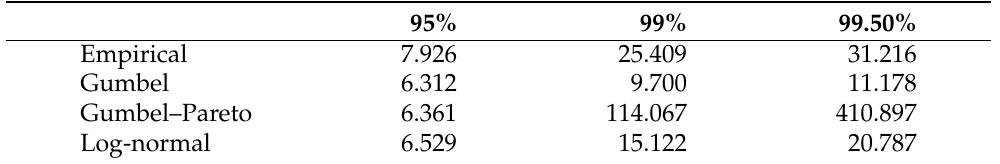
Table 5. Value-at-Risk for the empirical distribution and alternative distributions, obtained using Monte Carlo